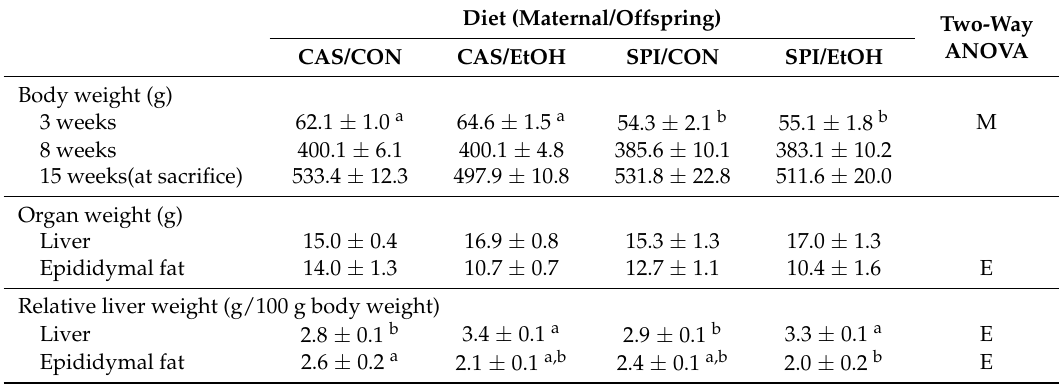
Table 1. Effects of maternal diet on body and organ weights in in ethanol-fed rat